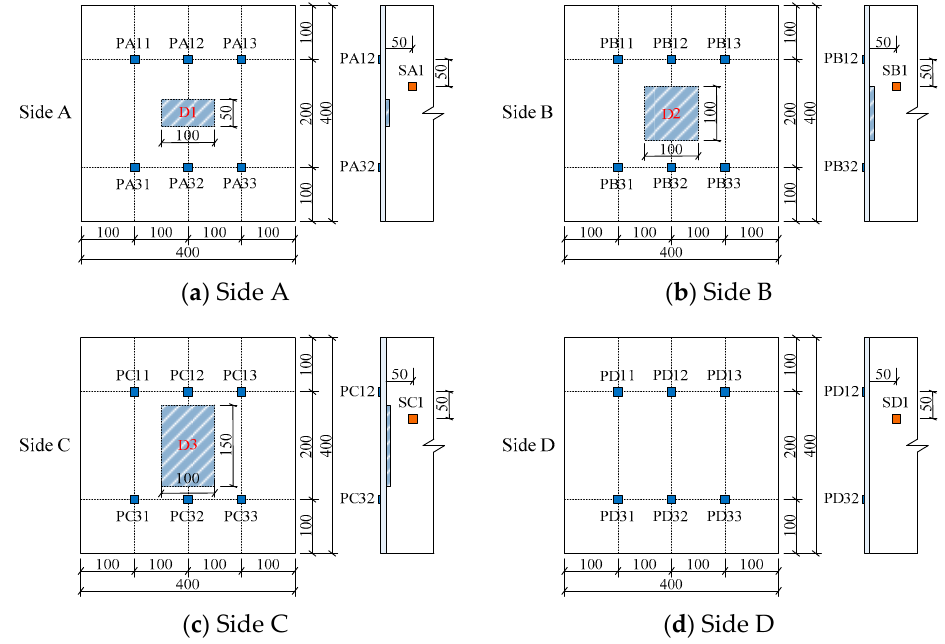
Figure 4. Arrangement of PZT patches, SAs and debonding defects in specimen No. 1 (unit: mm).